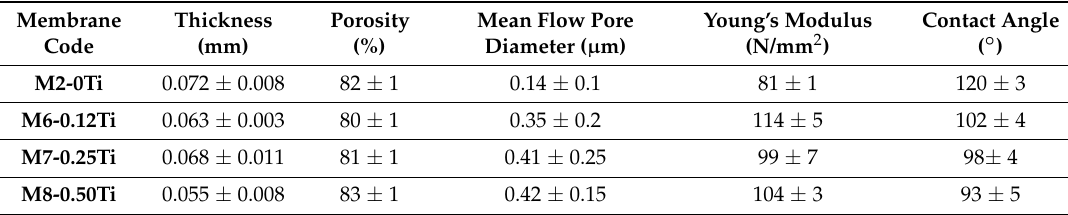
Figure 7. SEM-BSD (backscatter electron detector) pictures for TiO 2 particles distribution on top surfaces ( a ), bottom surfaces ( b ) and cross sections ( c ) of M2, M6, M7, and M8 membranes. Table 4. Membrane characterization for different amounts of TiO 2